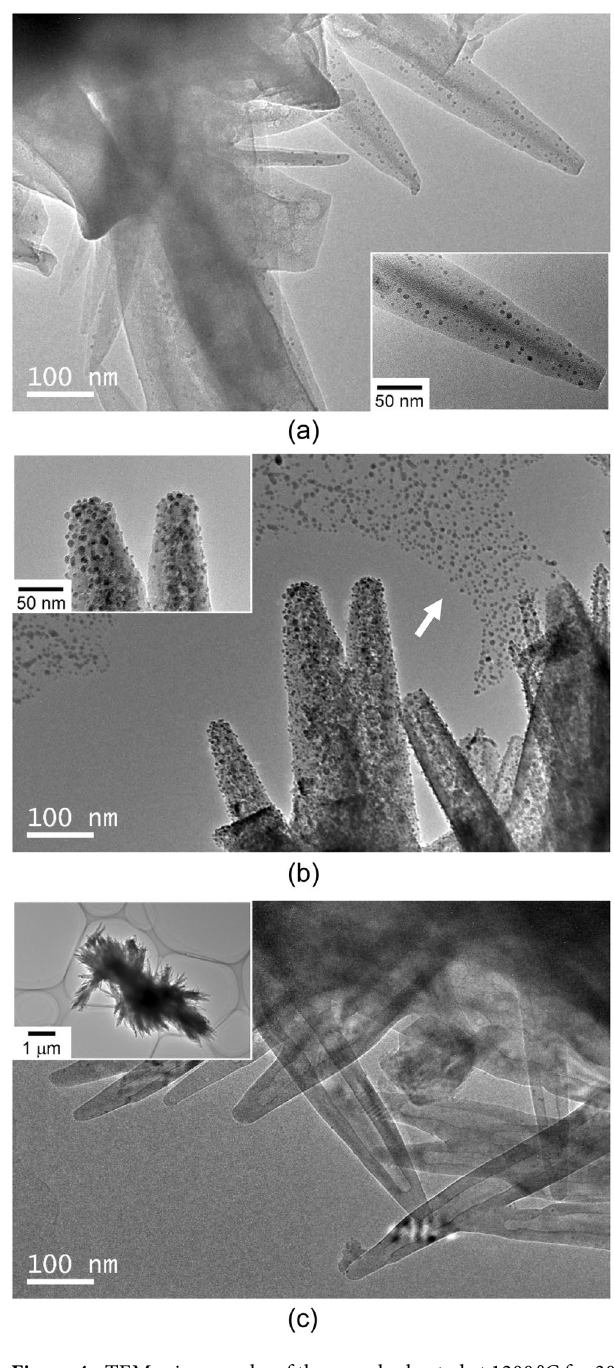
Figure 4. TEM micrographs of the samples heated at 1200 °C for 30 s ( a ), 50 s ( b ) and 100 s ( c ). The inset right below in ( a ) is the high magnification image showing the sparse nucleation. The inset left above in ( b ) highlights the high density nucleation of α -Al 2 O 3 nanocrystallites. The inset left above in ( c ) is the low magnification image indicating the morphology of the